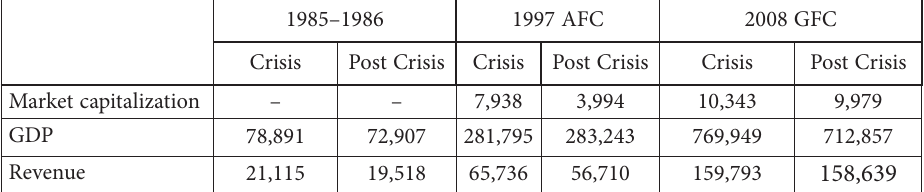
Table 1. Malaysia’s financial market, growth and taxation (in RM million) (source: Ministry of Finance Malaysia, 2016)